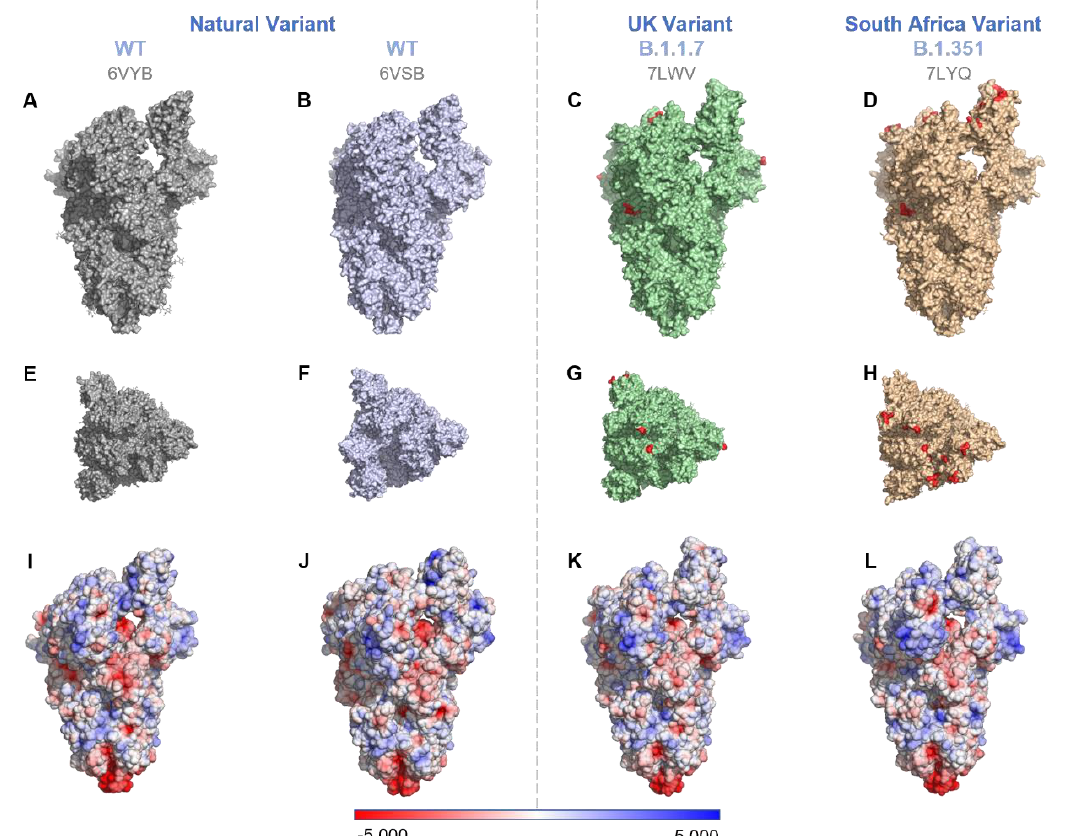
Figure 2. Comparison of the mutations (Rows 1 and 2) and surface electrostatic potentials (Row 3) on spike proteins of two VOIs with respect to the WT. WT (PDB ID: 6VYB [24] (1st column) and 6VSB [25] (2nd column)), B.1.1.7 (PDB ID: 7LWV [22]), and B.1.351 (PDB ID: 7LYQ [22]). ( A – D ) show the side view, 1st row; ( E–H ) show the top view, 2nd row. For the VOIs, the AA mutations on the S proteins (see Table 2 for details) are marked red with one residue before and after the actual mutational site for better visibility. ( I–L ) S-protein surface potentials of the WT and VOIs. The surface potentials were generated by preparing molecules with the pdb2pqr method and applying APBS electrostatics using PyMol